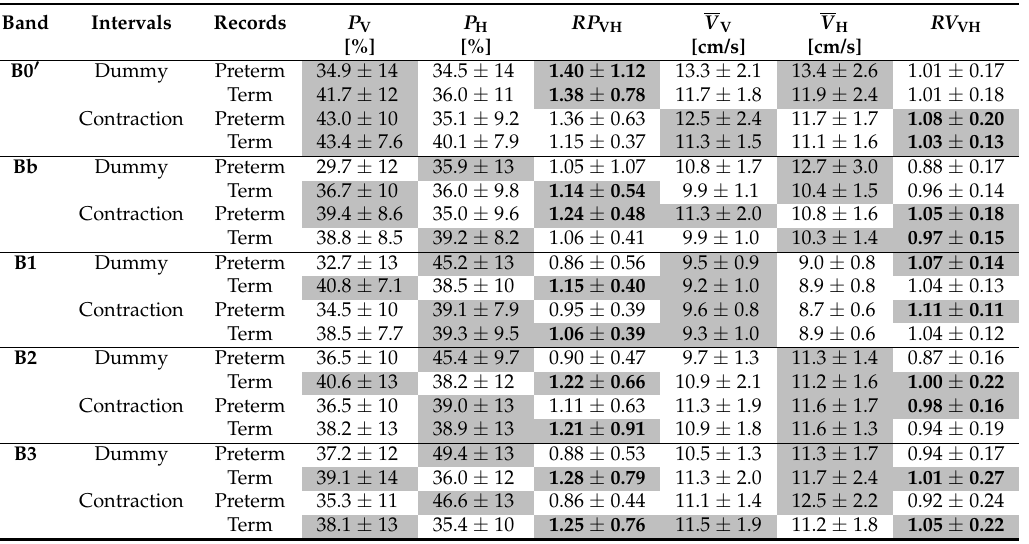
Table 2. Percentages of correlation intervals with the velocity vector in the vertical, P V , and horizontal, P H , directions, their ratios, RP VH , the average conduction velocity amplitudes in the vertical, V V , and horizontal, V H , directions, and their ratios, RV VH . All statistics are aggregate averages over all dummy and contraction intervals. The highest percentages (and the highest velocities) per vertical or horizontal direction, per type of interval, and per type of record are shaded in gray. The highest two ratios of the percentages (and of velocities) per frequency band are shaded in gray and in